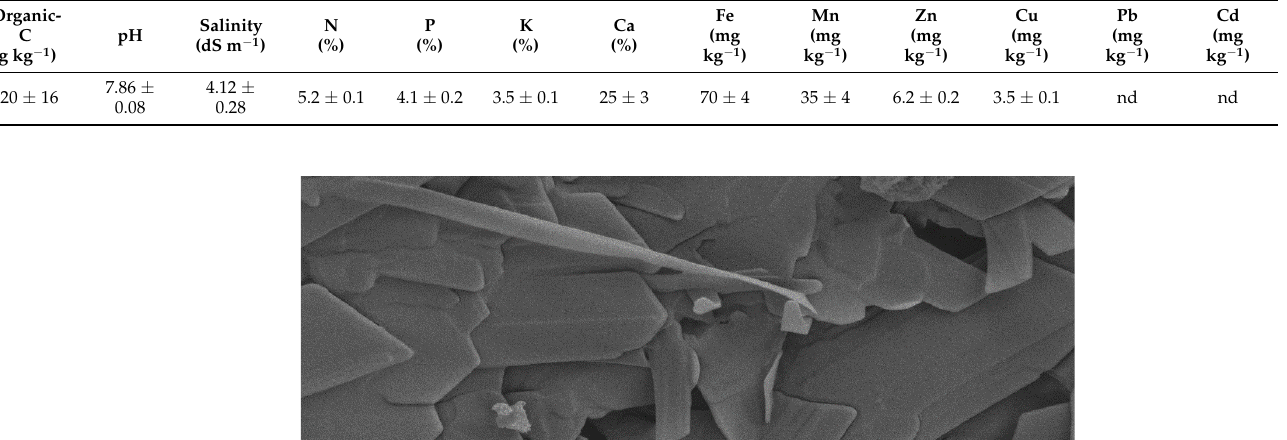
Table 1. Characterization of shrimp-waste-derived biochar (SWB). nd = not detected. Organic- C